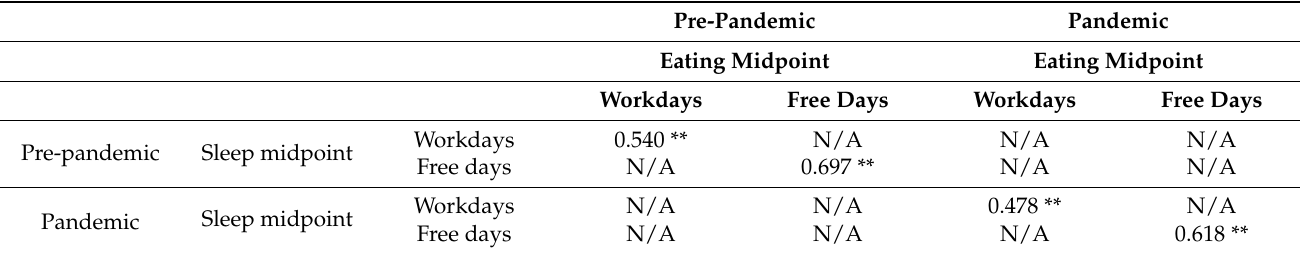
Table 2. Spearman correlation between sleep and eating midpoints before and during the pandemic. The table reports Spearman rank-order correlation coefficients. ** p value smaller than 0.0125 (Bonferroni corrected). Abbreviations: N/A, not